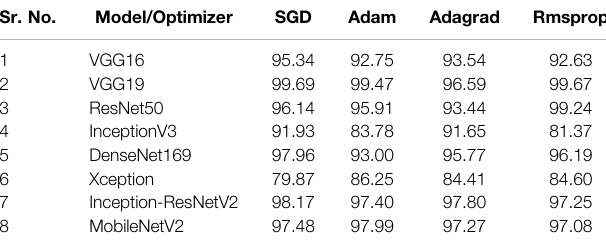
TABLE 6 | Performance evaluation based on testing accuracies for two-class classi fi cation [Accuracy (%)]. Sr.